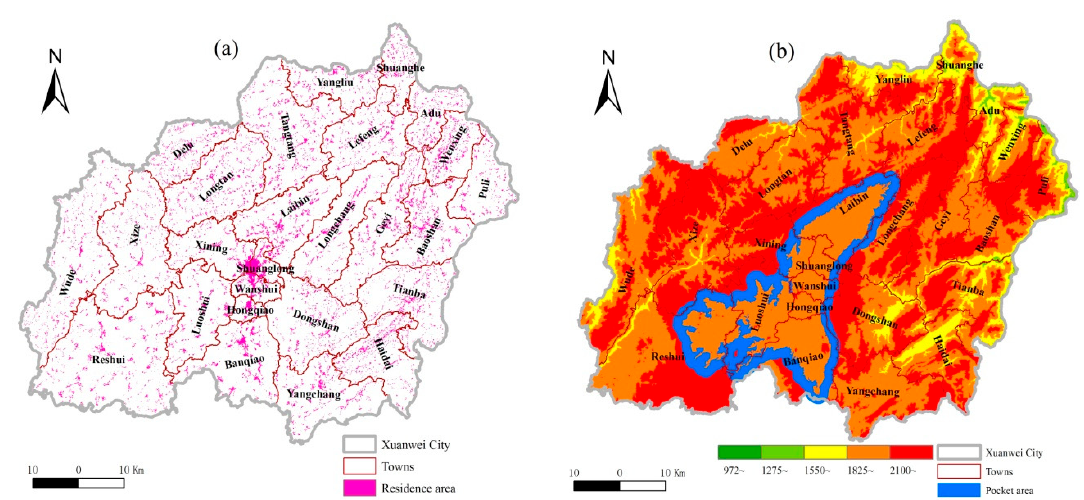
Figure 2. Residential area ( a ) and featured topography ( b ) in Xuanwei.